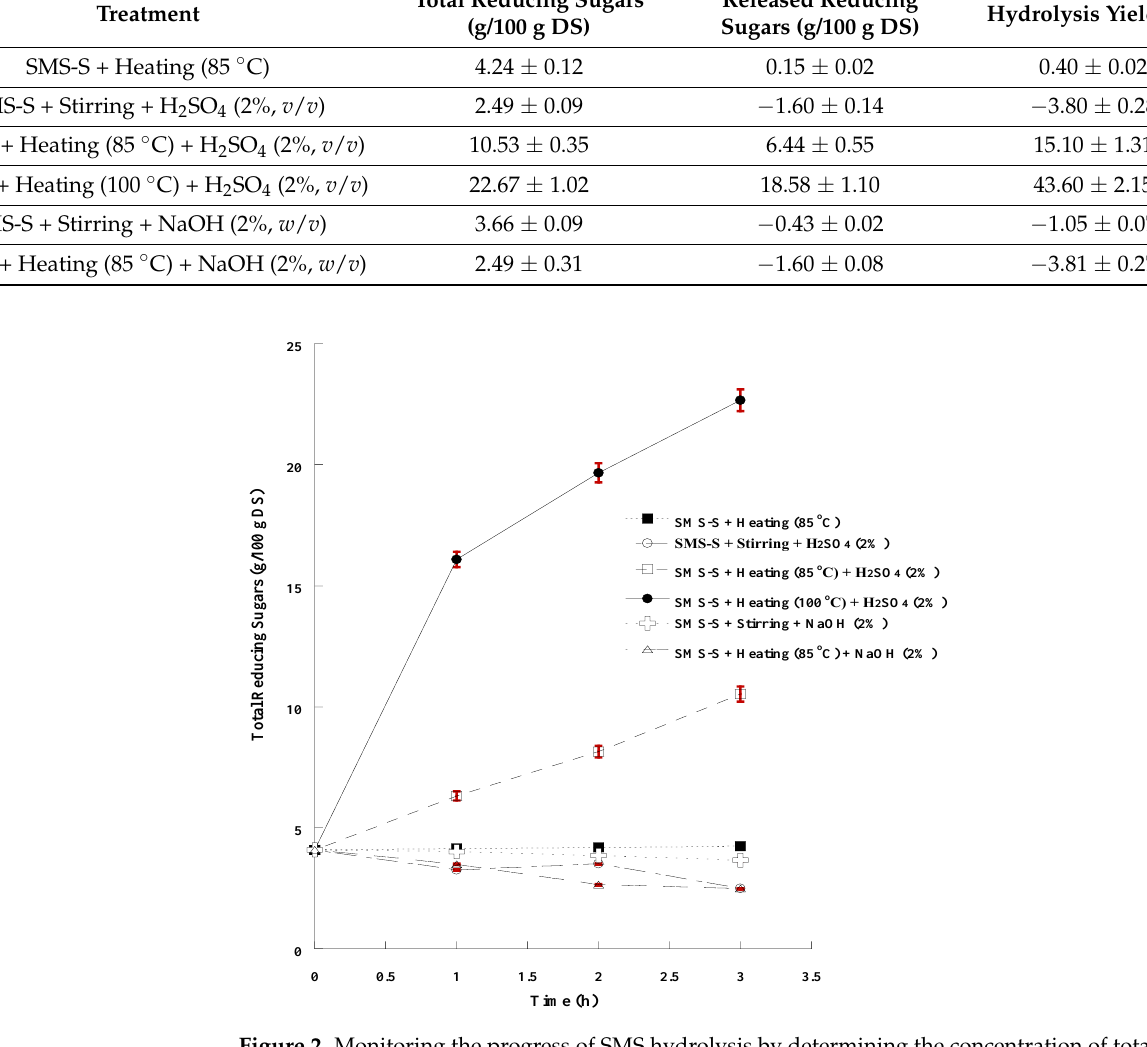
Table 4. Quantitative data originated from various combinations of thermal and/or chemical hydrol- ysis of SMS. The presented results are the mean of two independent analyses.